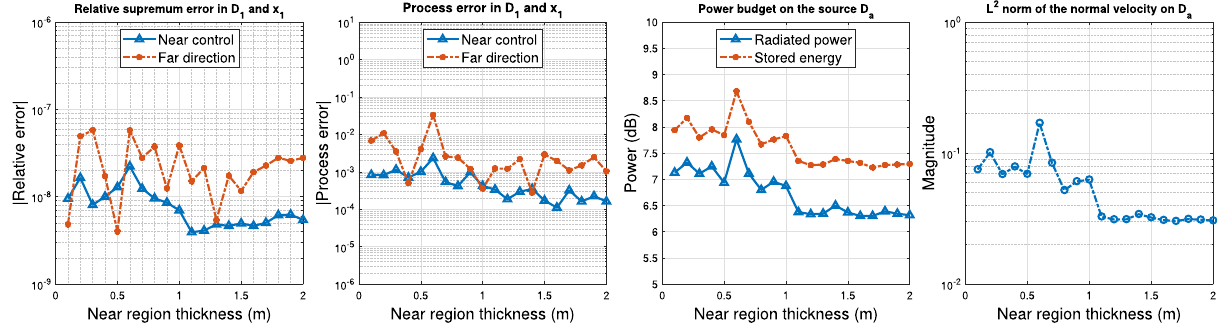
Figure 11. Results showing the control accuracy and the power budget varying with the size of the near control D 1 . The size of D 1 is the difference between the outer and inner radii, i.e., the thickness of the sectorial region. From left to right, (1) Supremum error. (2) Process error. (3) Power budget on D a . (4) L 2 norm of normal velocity v n on D a .